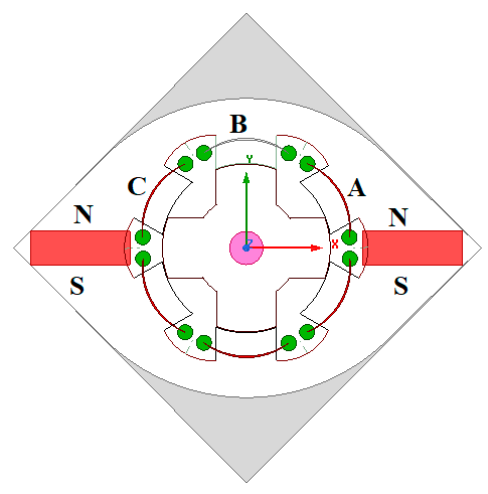
Figure 3. 3-phase, six / four-pole double salient permanent magnet (DSPM) machine [11].